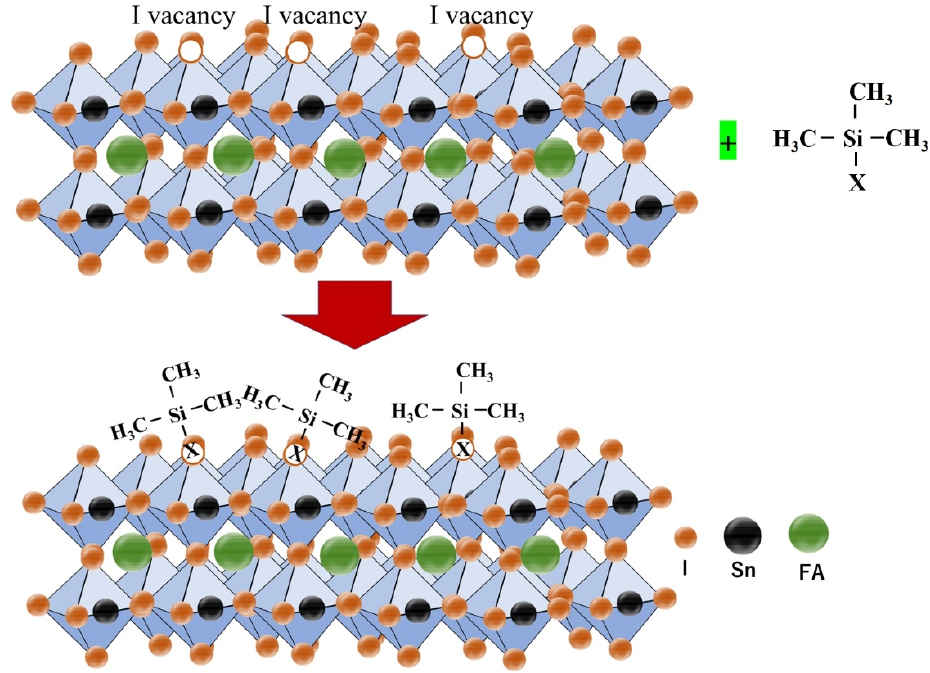
Figure 17. Halide passivation strategy using silyl halide as a surface passivating agent. Reproduced with permission [91]. Copyright 2022,